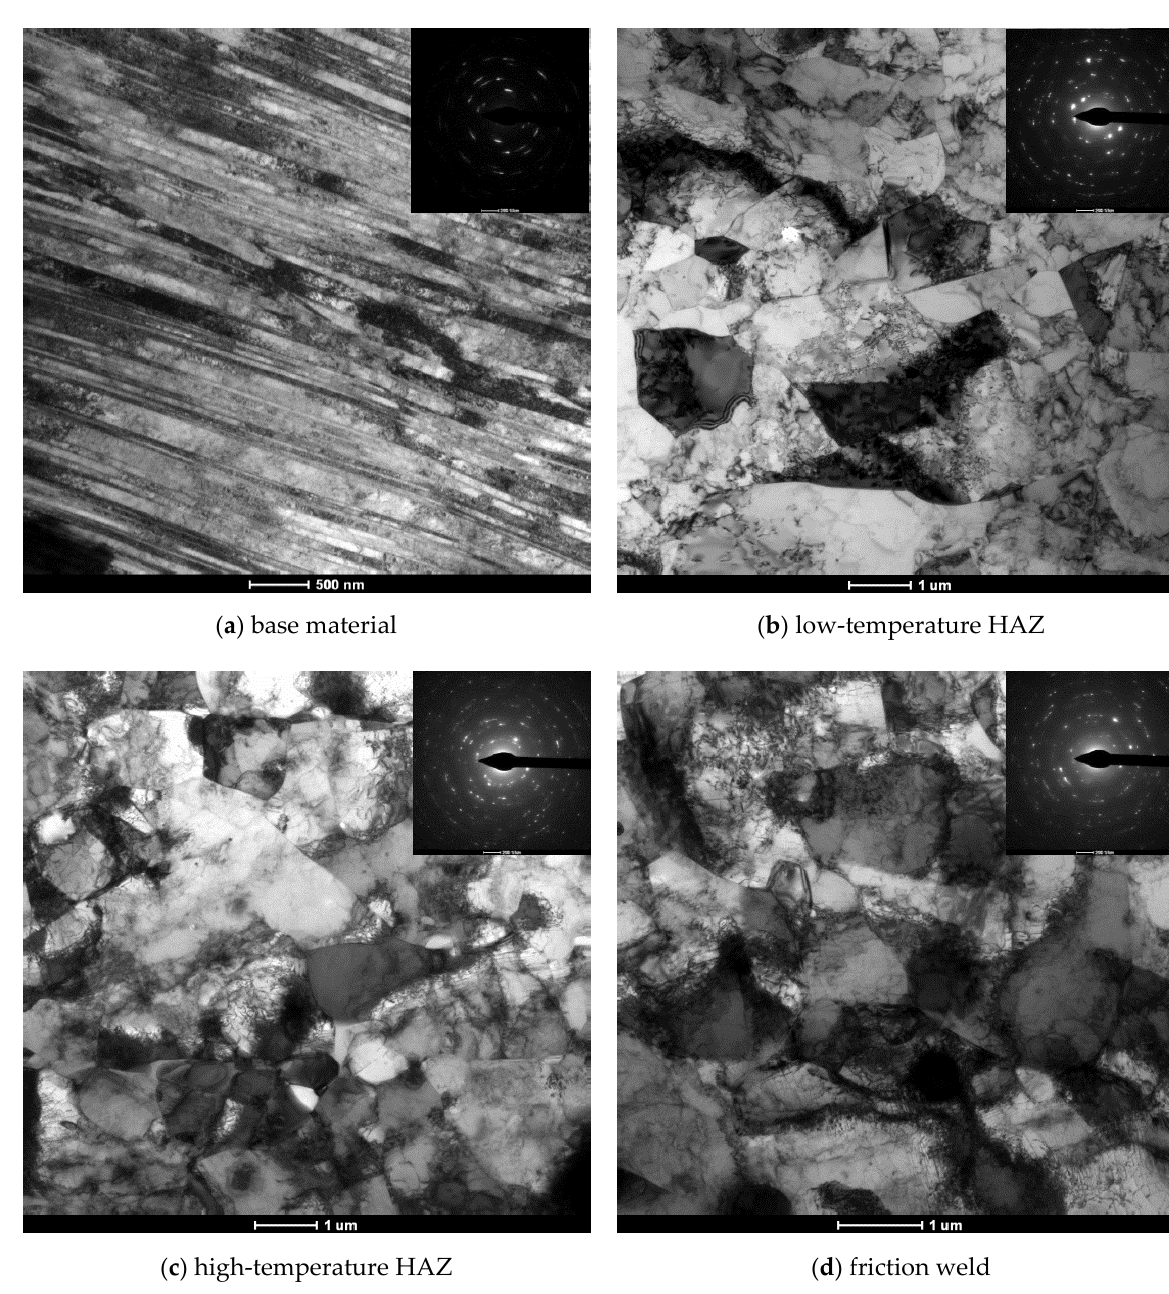
Figure 6. Bright field TEM images with corresponding SAED patterns obtained for ( a ) base material in longitudinal section to HE, ( b ) low-temperature HAZ, ( c ) high-temperature HAZ, ( d ) friction weld in transverse cross-section of the friction-welded joint.